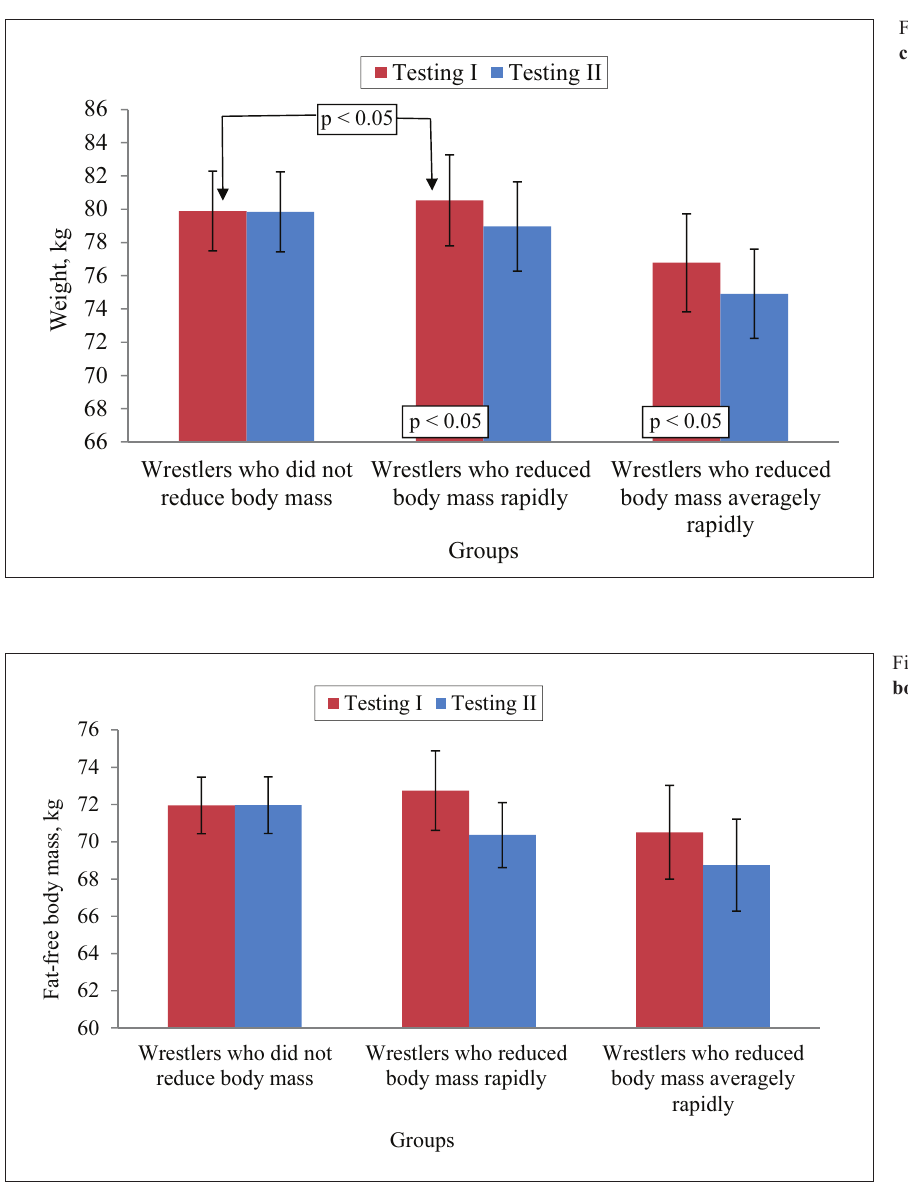
Figure 3. Wrestlers’ fat-free body mass changes